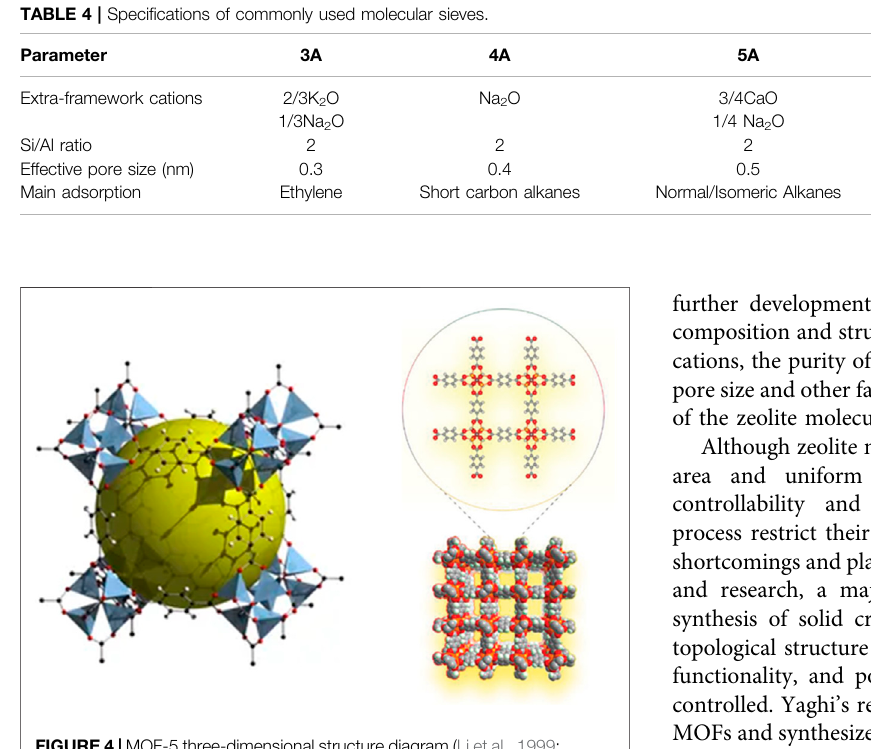
Frontiers in Chemistry |